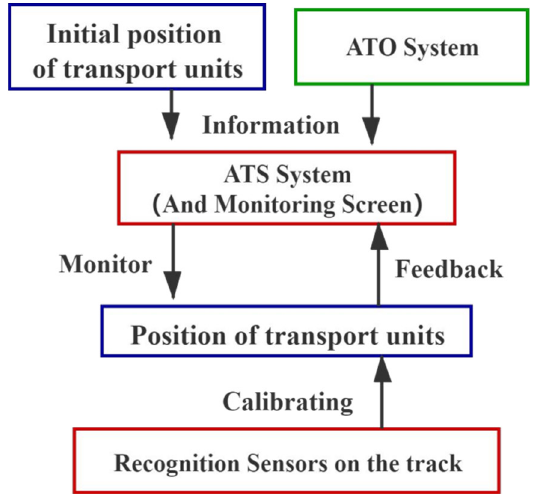
Figure 7. The real-time monitoring.